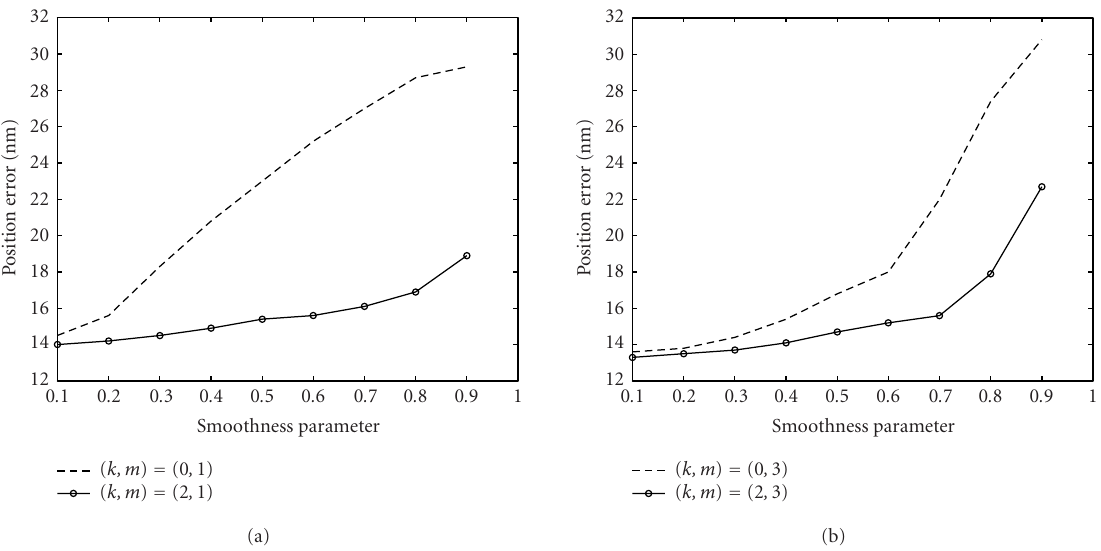
Figure 7: Position error for spline envelope: (a) ( k , m ) = (0,1), ( k , m ) = (2,1) and (b) ( k , m ) = (0,3), ( k , m ) = (2,3).